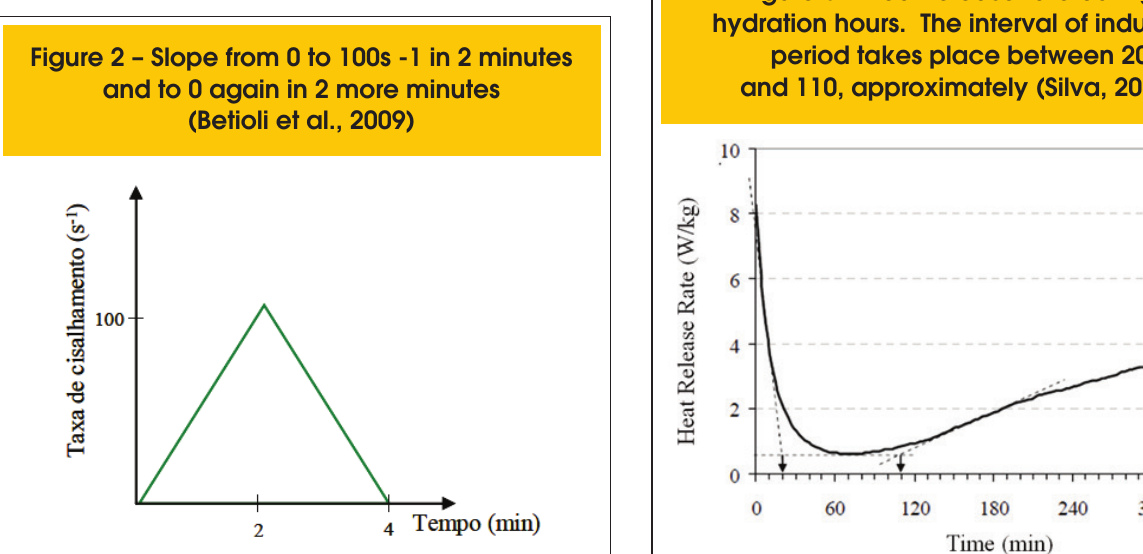
Figure 2 – Slope from 0 to 100s -1 in 2 minutes and to 0 again in 2 more minutes (Betioli et al., 2009)